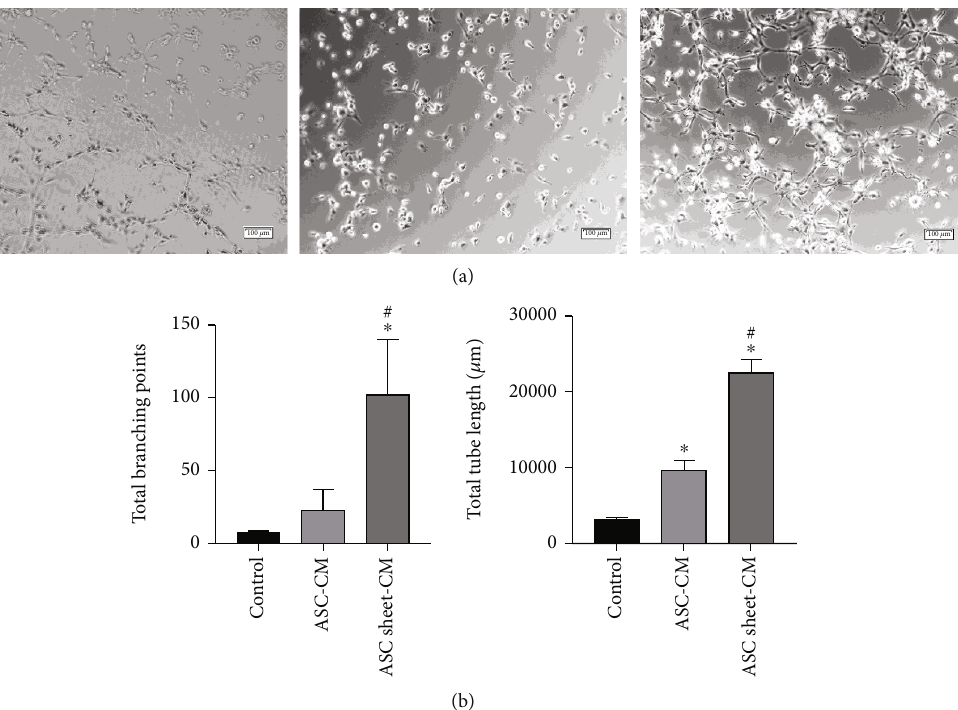
Figure 9: Angiogenic e ff ects of ASC-CM and ASC sheet-CM in tube formation assay. (a) Representative images of ECs that formed tubes on Matrigel at 6 h. Scale bars: 100 μ m. (b) Graph showing the number of total branching points and total tube length. ∗ p < 0 : 05 , versus the control group; # p < 0 : 05 , versus the ASC-CM